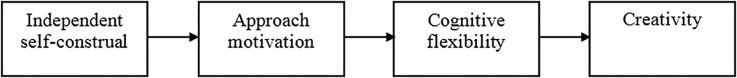
Linking self-construal to creativity: A three-stage mediation model.